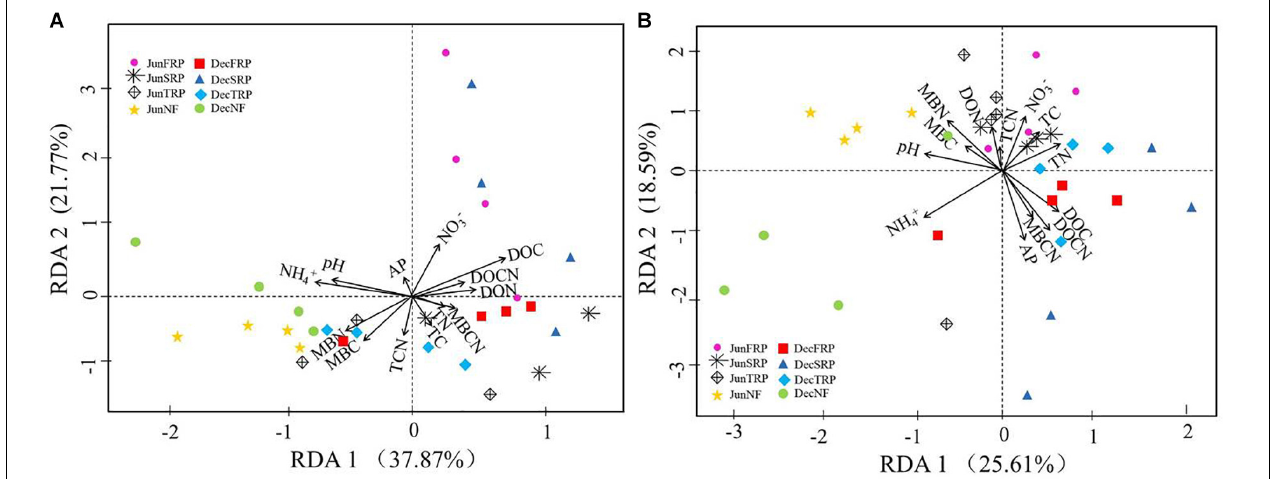
FIGURE 4 | Redundancy analysis (RDA) illustrating the effects of environmental factors (arrows) on fungal (A) and bacterial (B) community structure (symbols) across all soil samples in different plantations and sampling times (using combined December and June data). The values of axes 1 and 2 are the percentage that can be explained by the corresponding axis. Data points are from different plantations and sampling seasons (NF, natural forest; FRP, first rotation plantation; SRP, second rotation plantation; TRP, third rotation plantation; Dec, December; Jun,